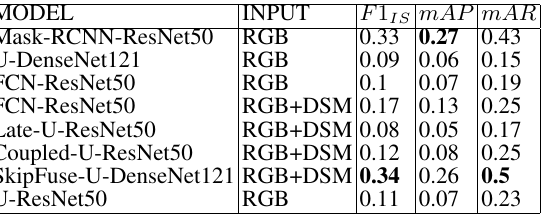
Table 2. Quantitative results without